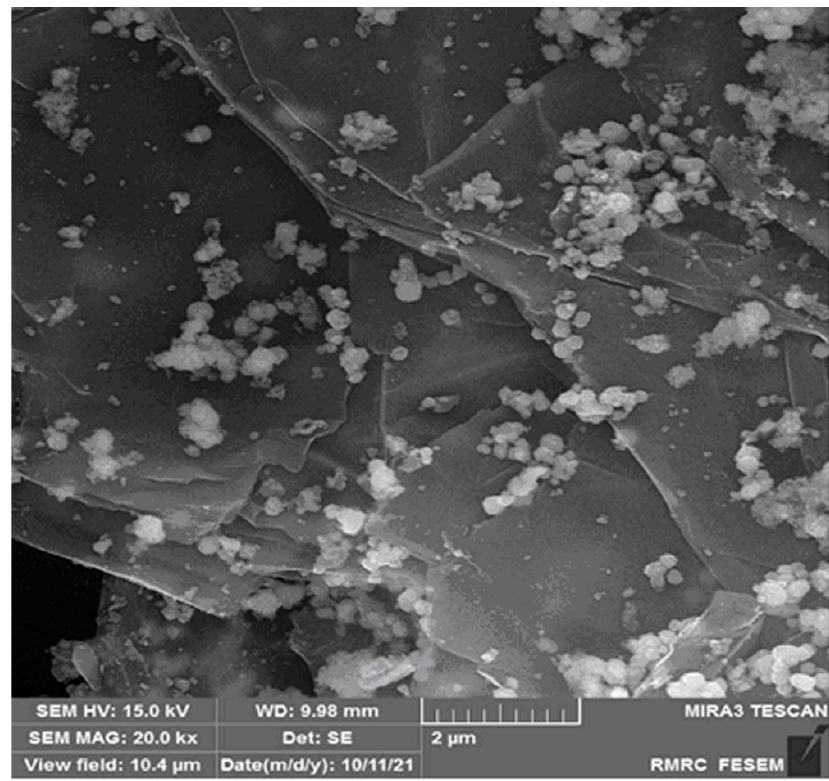
Figure 2. The FE-SEM image of graphene-Co 3 O 4 nanocomposite. The EDS spectrum (Figure 3) also shows the existence of C, O, and Co elements in the graphene-Co 3 O 4 nanocomposite.